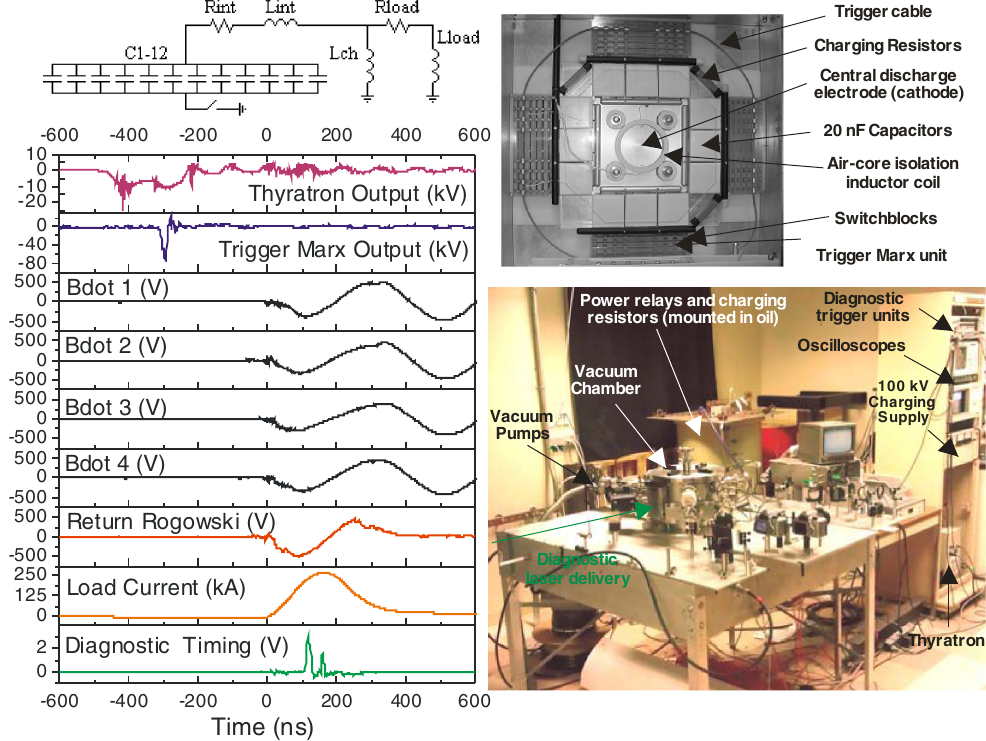
FIG. 1. Present configuration of the GenASIS LTD driver at UC San Diego. The circuit diagram is the representative model used for circuit simulations, plots show timings for electrical diagnostics during the trigger sequence, the upper image shows the interior of the cavity, and the lower image shows the device in the